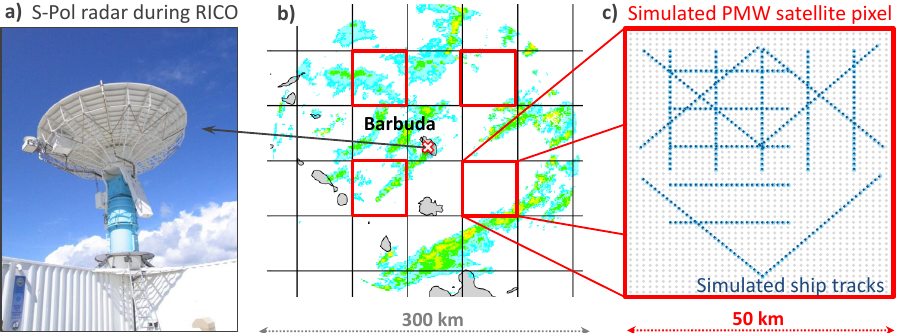
Figure 1. Photo ( a ) shows S-Band Polarimetric (S-Pol) radar during RICO (Rain In Cumulus clouds over the Ocean; Copyright University Corporation for Atmospheric Research (UCAR) by Gordon Farguharson, licensed under CC BY-NC 4.0 License via OpenSky). Example of S-Pol radar image interpolated on Cartesian grid ( b ) with red boxes that are chosen to simulate the satellite pixels. Enlarged red box ( c ) illustrates 16 randomly chosen synthetic ship tracks (blue dotted lines; 5 horizontal, 5 vertical, 6 diagonal) of 60 radar pixels, each corresponding to a typical ship speed of 24–34 km h − 1 depending on track orientation. For clarity, the number of sketched radar pixels is only one tenth of the original grid (Section 2.2). PMW: passive